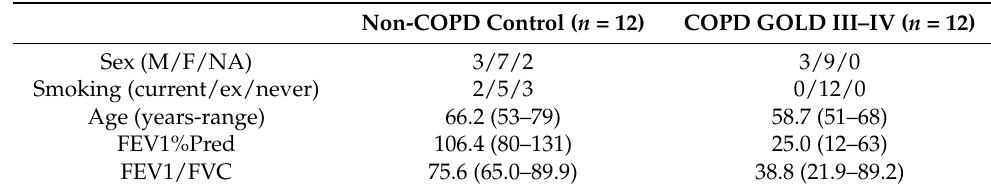
Table 1. Characteristics of subjects included in the